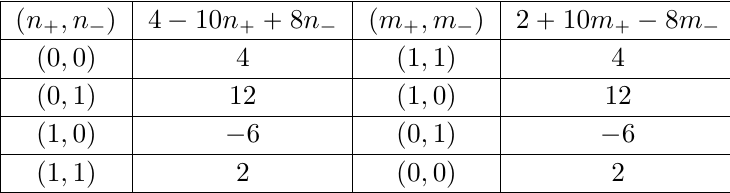
Table 5 . Low-lying operator exchanges corresponding to the correlator